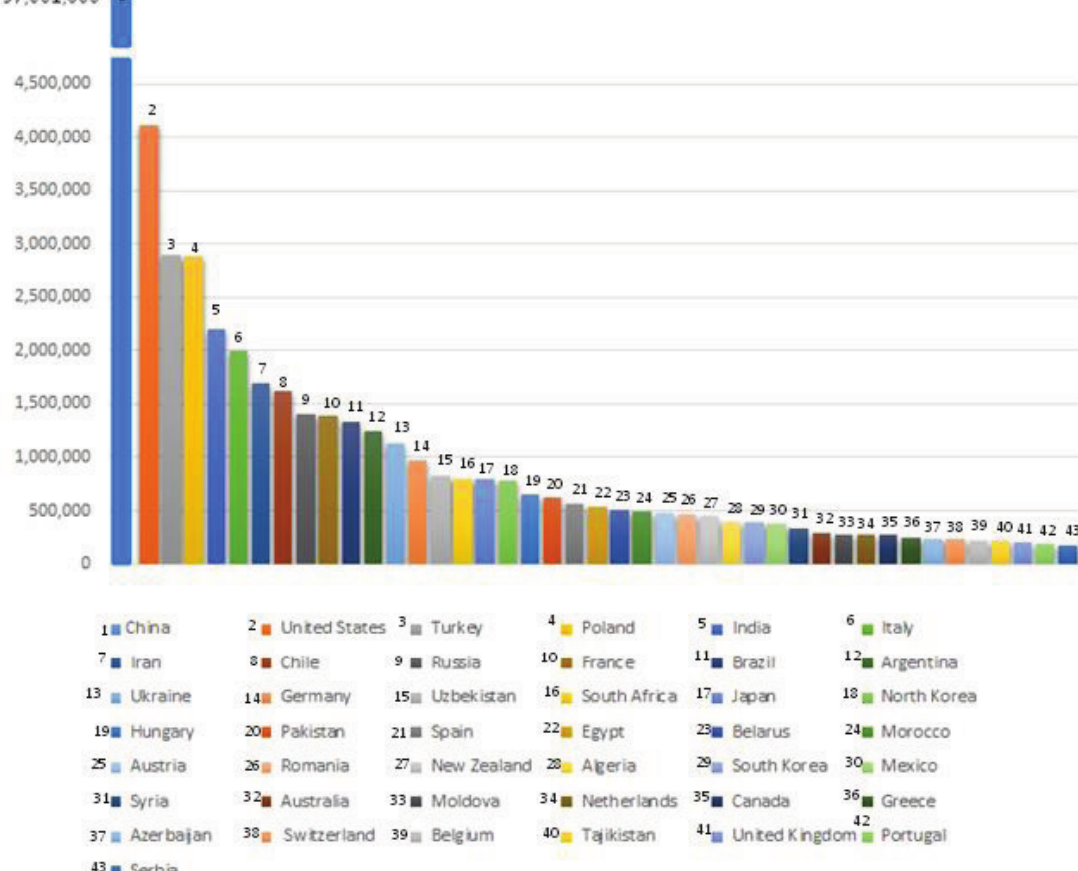
Figure 1 Worldwide leading countries in apple production. Rank is given per ‘legend line’ and stated as average tons for 2012 (source: FAO).